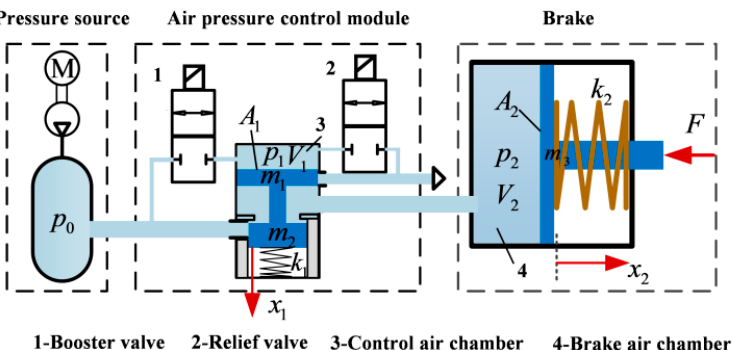
Figure 4. Schematic diagram of the EPV module dynamic characteristic analysis.